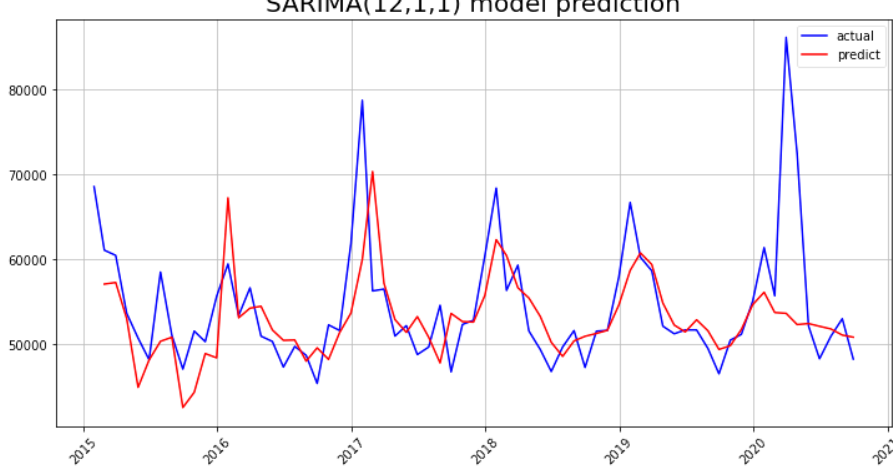
Figure 15. Prediction of the model respect the deaths observed from 2015 to September 2020 in